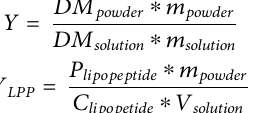
( Supplementary Table S1A ) or LPPs in solution sampled at different steps of the LPP production and puri fi cation using membrane ultra fi ltration work fl ow ( Figure 1 ; Supplementary Table S1B ). LPPs (surfactin, mycosubtilin, and